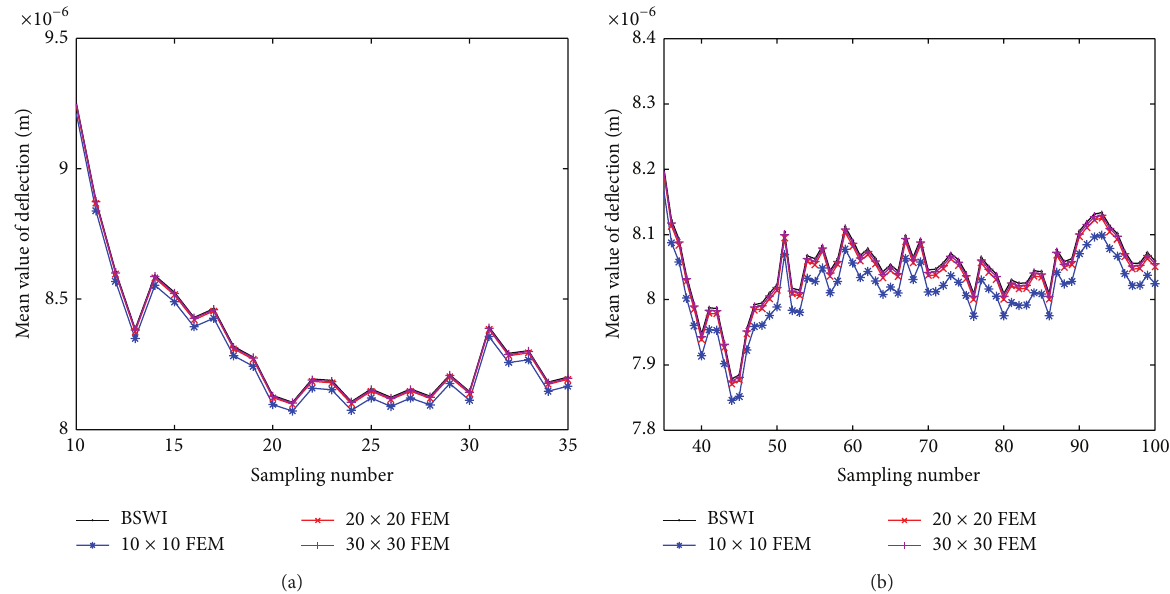
Figure 12: Relationship between the mean value of plate center deflection and sampling number: (a) sampling number 10–35, (b) sampling number 35–100.